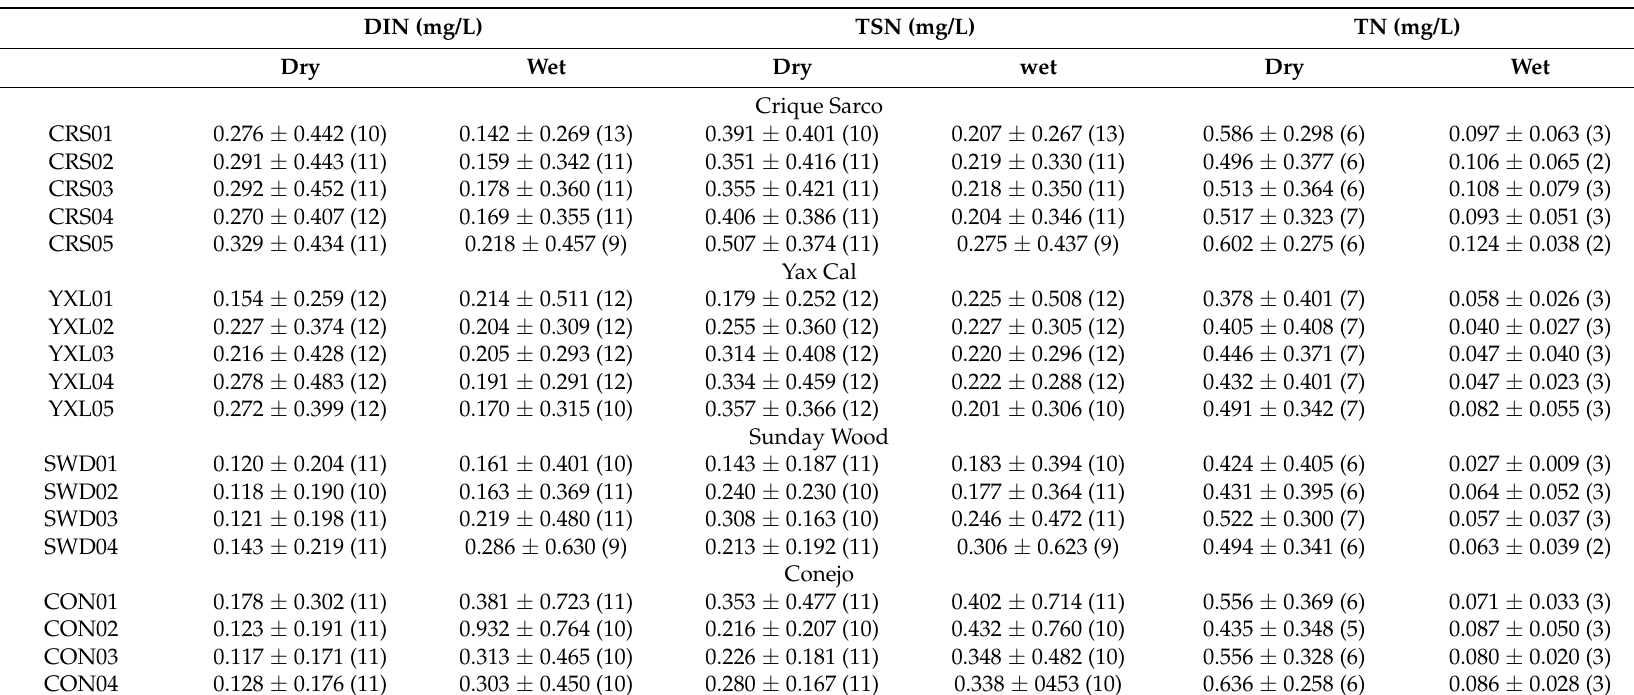
Table 4. Mean seasonal nutrient concentrations for dissolved inorganic nitrogen (DIN), total soluble nitrogen (TSN), and total nitrogen (TN) for all sampling sites within each study catchment. Values are mean ± 1 standard deviation (sample size in